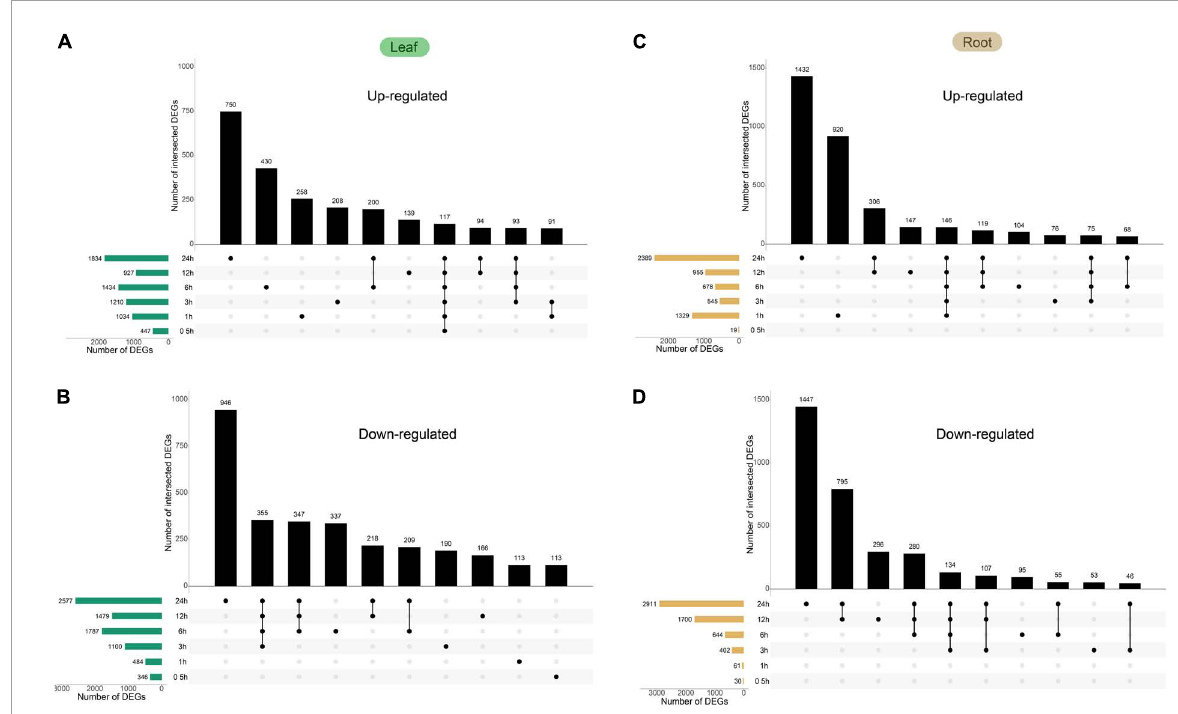
FIGURE5 Time-course transcriptomics analysis of Capsicum annuum L. under heat. Plants were subjected to 42 ◦ C treatment for the indicated time. The total numbers of significant genes at each time point are shown on the left. (A) Upregulated genes in the leaf. (B) Downregulated genes in the leaf. (C) Upregulated genes in the root. (D) Downregulated genes in the root. All the DEGs in roots and leaves are shown in Supplementary Table 5 .